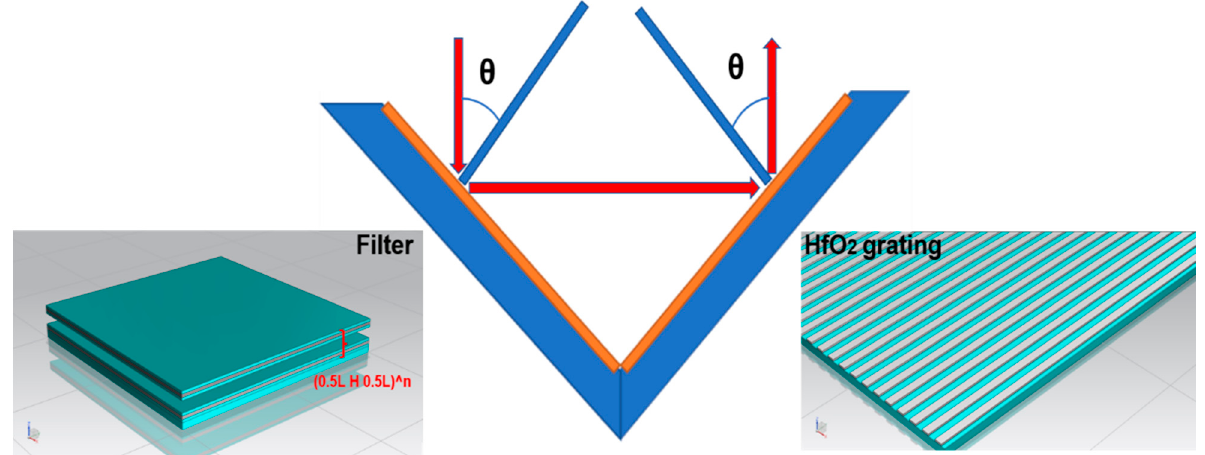
Figure 2. Schematic diagram of incident light after passing through filter and